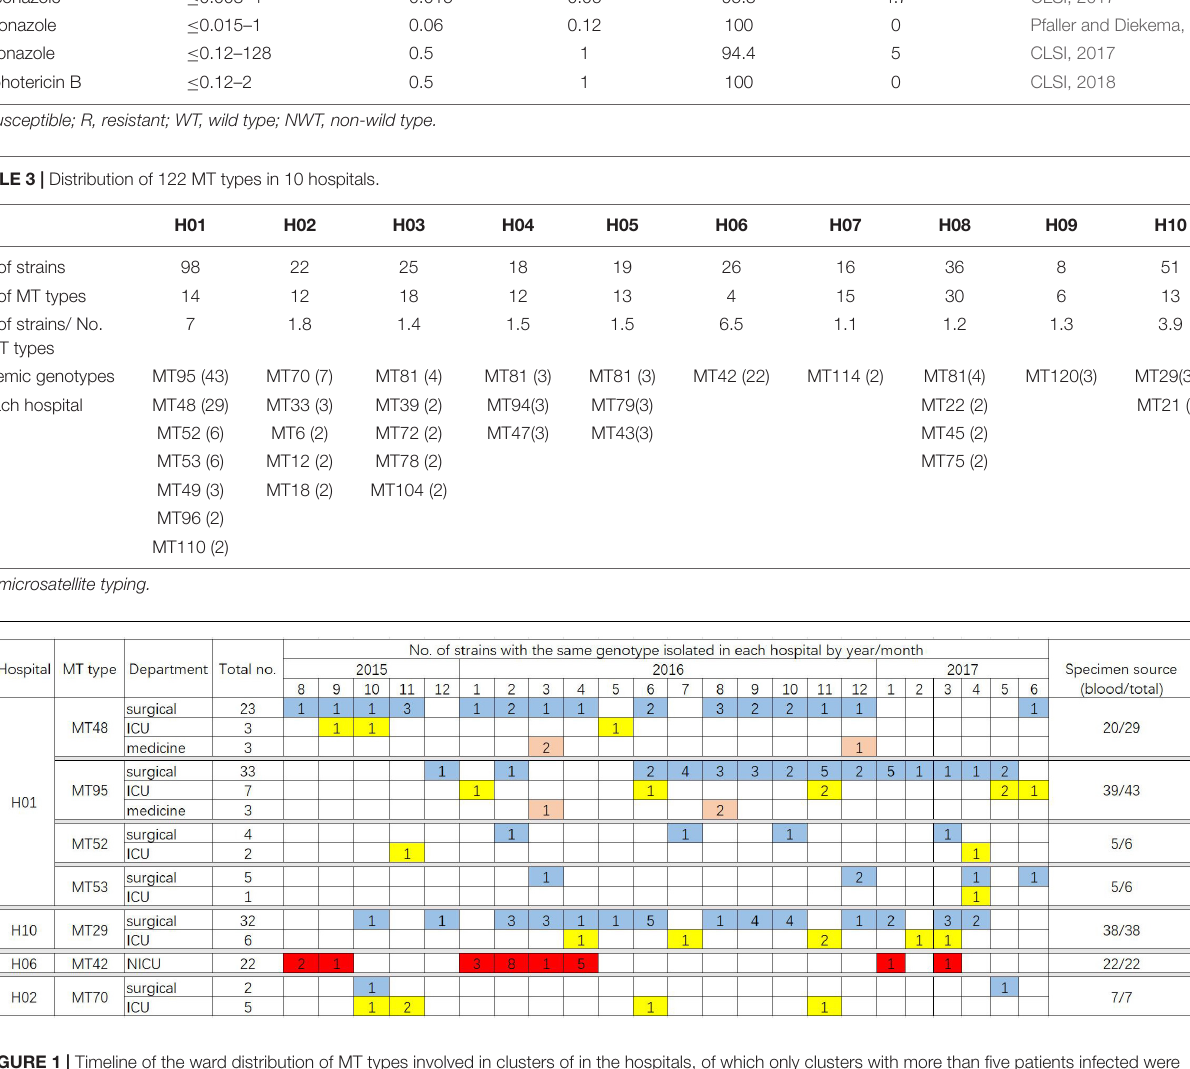
(total n = 29). The MT95 genotype was evident in isolates